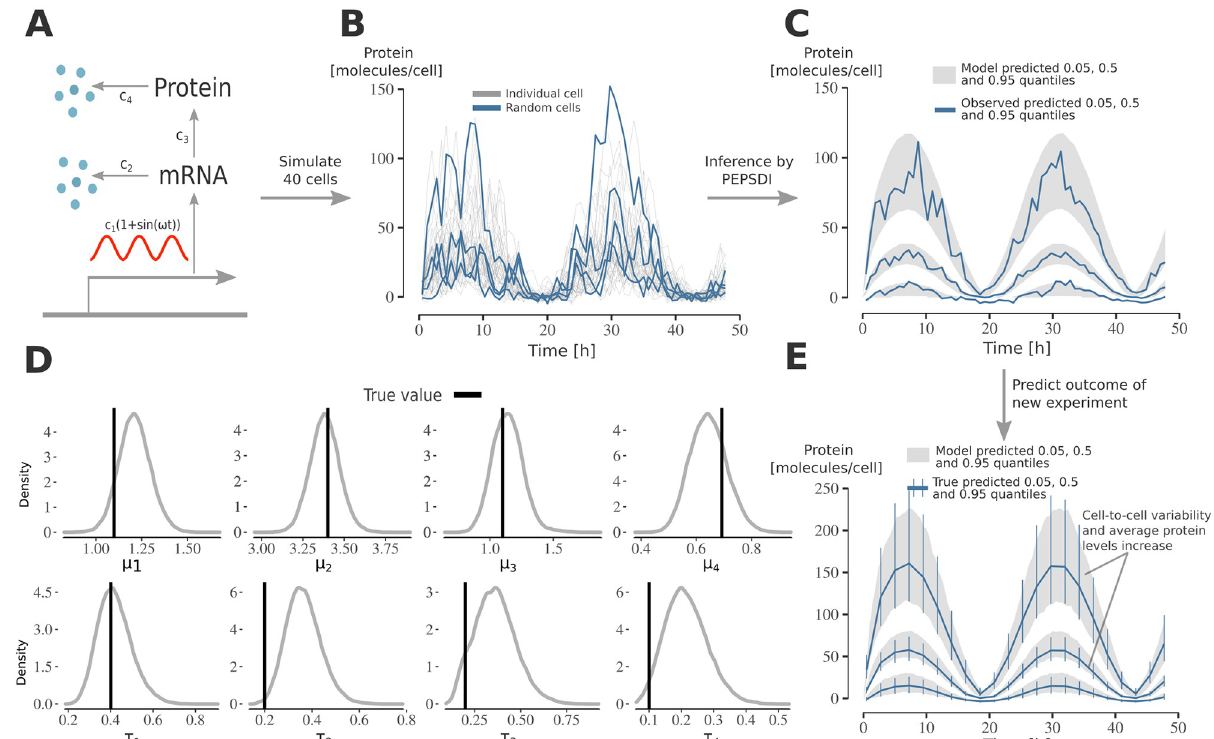
Fig 2. Applying PEPSDI on synthetic data from circadian clock gene expression model. A) Schematic representation of the gene expression model. The model consists of two states (mRNA, Protein), and four reactions with associated rate constants c = ( c 1 , ... , c 4 ). The circadian clock, modelled as a sine function with a period of 24 hours, regulates the transcriptions activity c 1 . Extrinsic noise was simulated by assuming that rate-constants jointly follow a log-normal distribution: c � LN ð μ ; Ω Þ . B) Protein count per cell for 40 cells simulated using the gene-network model. Data was simulated using the exact Extrande algorithm with an additive Gaussian measurement noise. C) Posterior visual checks [30]. The plot was generated as follows: i) from the inferred posterior distribution, simulate 40 cells, and ii) for trajectories corresponding to the 40 cells compute their 0.05, 0.5, 0.95 quantiles at each time point. This was repeated 10, 000 times independently and we then computed the 95% credibility intervals for these quantiles. The blue lines correspond to the observed quantiles (from the data in (B)). D) Inference results using the data in B). The plots shows the marginal posterior for μ = ( μ 1 , ... , μ 4 ) and τ = diag{ Ω } 1/2 . E) Using the inferred model to predict the outcome of adding an extra gene in the model. An extra gene was modelled by doubling the transcription rate c 1 . The grey lines represent 95% credibility intervals for the 0.05, 0.5 and 0.95 quantiles (obtained as in subplot (C)) when simulating the inferred model with c 1 doubled. The blue lines and error bars represent the true 95% credibility intervals when observing 40